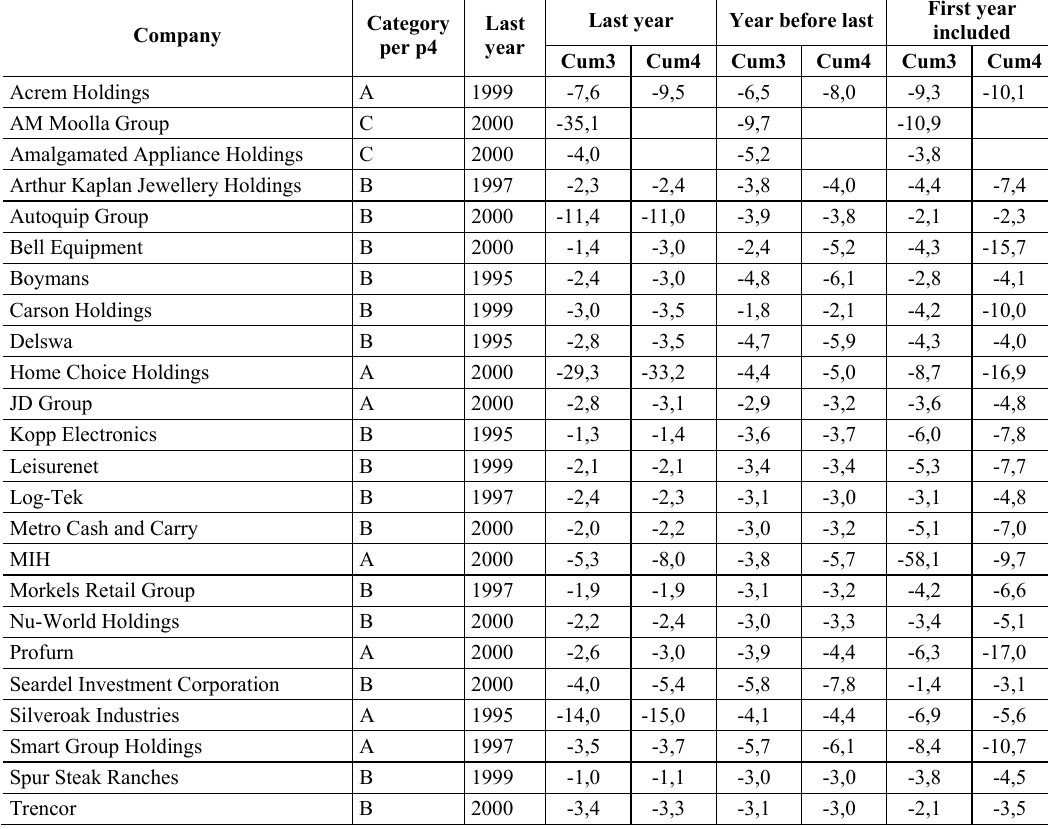
Table 4: Companies with large negative